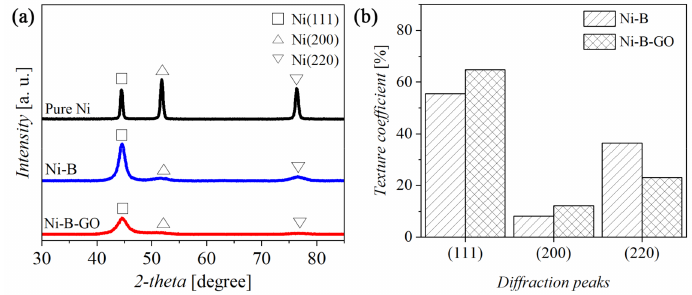
Figure 4. ( a ) XRD patterns and ( b ) texture coefficient of the coatings.